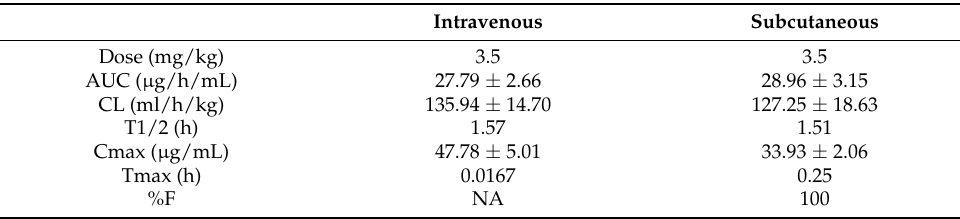
Table 2. Summary of pharmacokinetic parameters for HPS in mice.